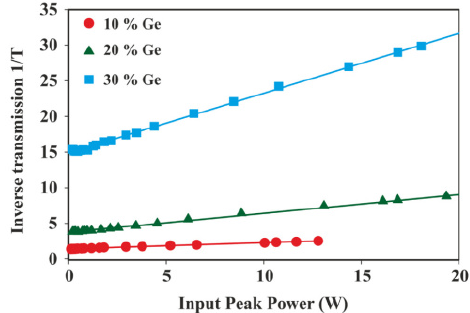
Figure 8. A plot of the inverse transmission vs. coupled input peak power measurement for a waveguide of 2 μ m width and varying Ge concentrations [55].